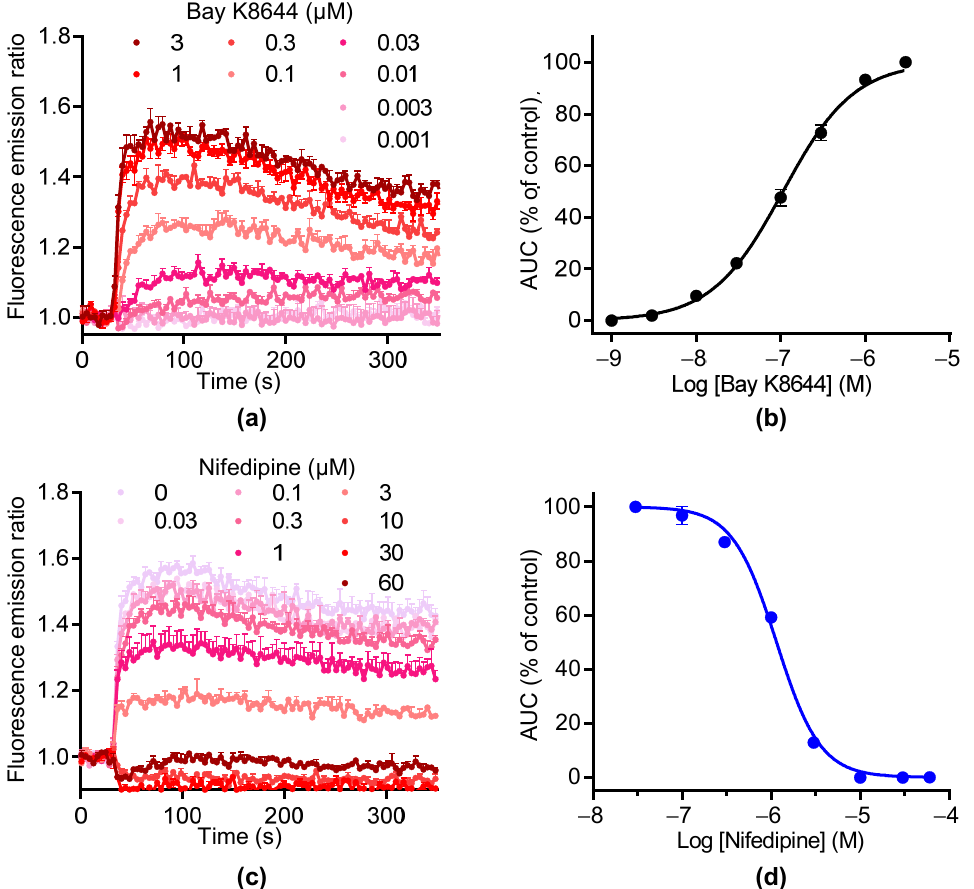
Figure 3. BAY K8644 activates LTCC channels in GH3b6 cells. ( a ) Example of kinetic traces of Fura-2 emission fluorescence induced by increasing concentrations of BAY K8644. ( b ) Concentration– response curve of BAY K8644-evoked Ca 2+ responses. ( c ) The kinetic traces show that the Ca 2+ responses induced by 1 µM of BAY K8644 were inhibited by nifedipine in a concentration-dependent manner. ( d ) Inhibition–concentration curve of nifedipine. ( b , d ) The AUC of kinetic traces were normalized to maximal response (% of control) and analyzed using Hill–Langmuir equation with variable slope. Data are means ± SEM ( n = 3). These experiments were repeated twice.